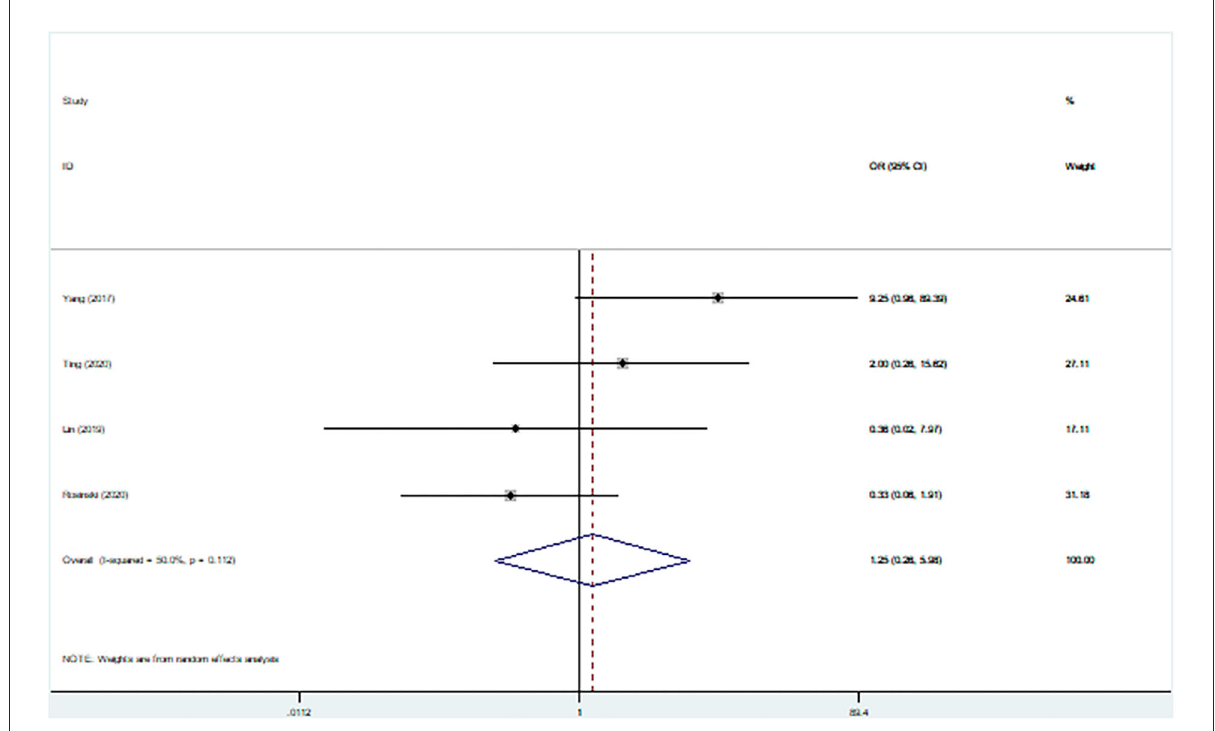
FIGURE8 Comparisons of reoperation rates for staged and simultaneous cranioplasty and ventriculoperitoneal